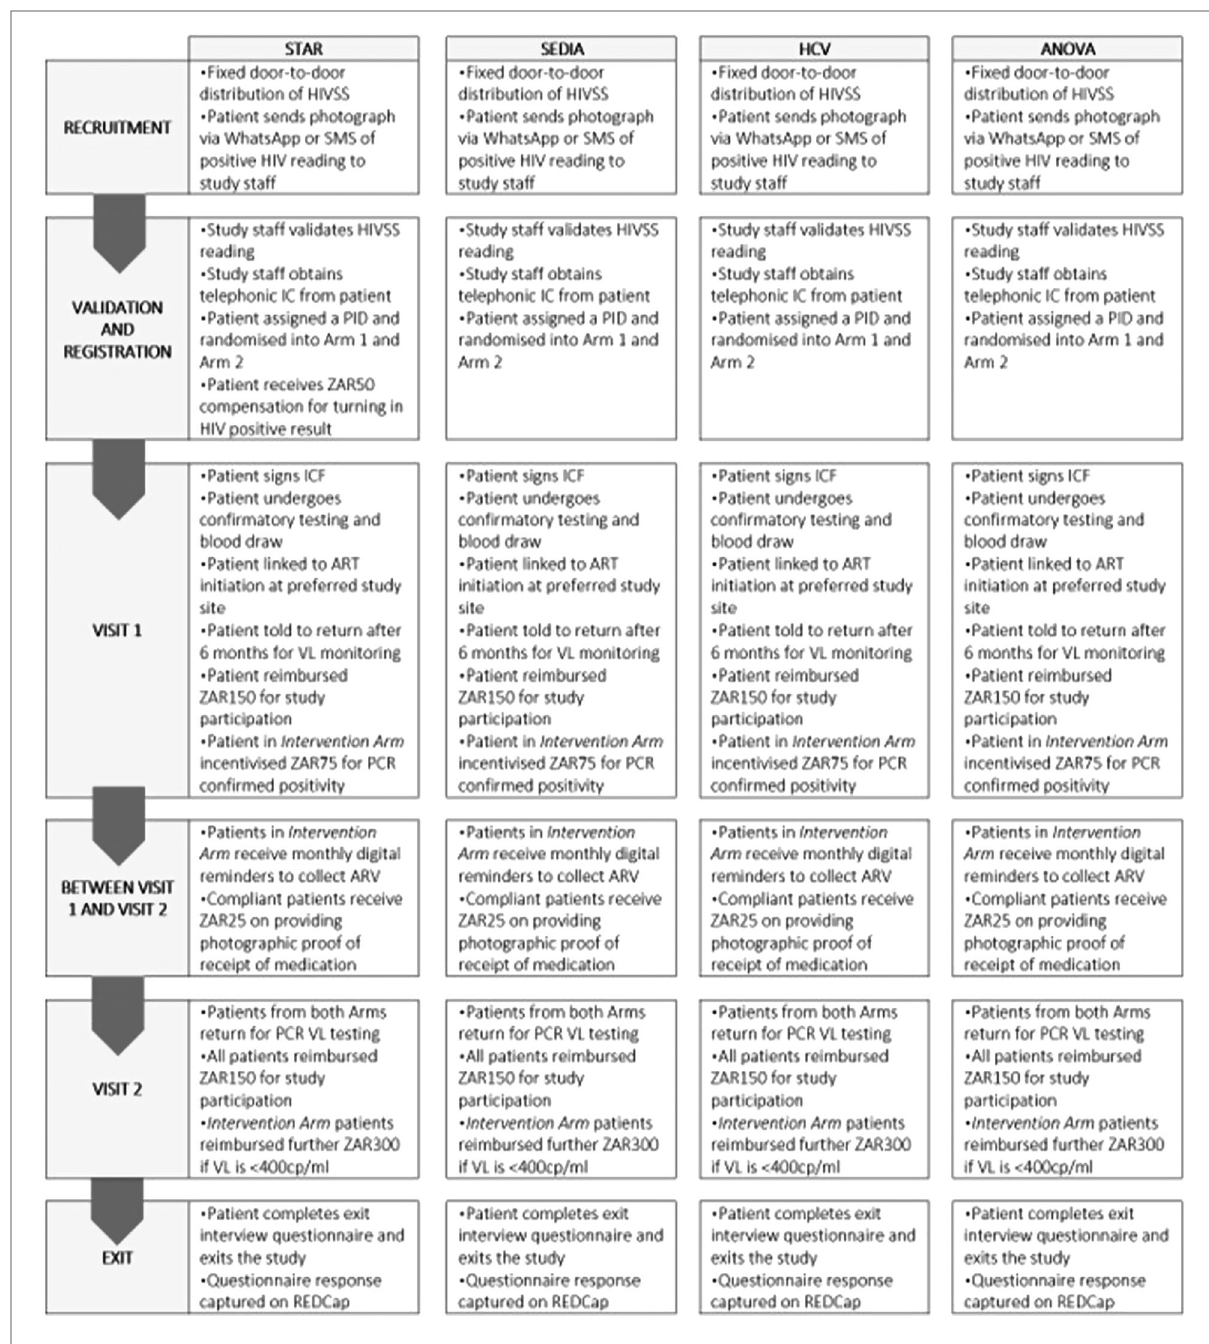
FIGURE 2 Work study process per recruitment group. HCV, hepatitis C virus; HIVSS, HIV self-screening; SMS, short messaging services; IC, informed consent; PT, participant; PID, patient identi fi cation; ICF, informed consent; ART, antiretroviral therapy; VL, viral load; PCR, polymerase chain reaction; ZAR, South African rand; cp/ml, copies per